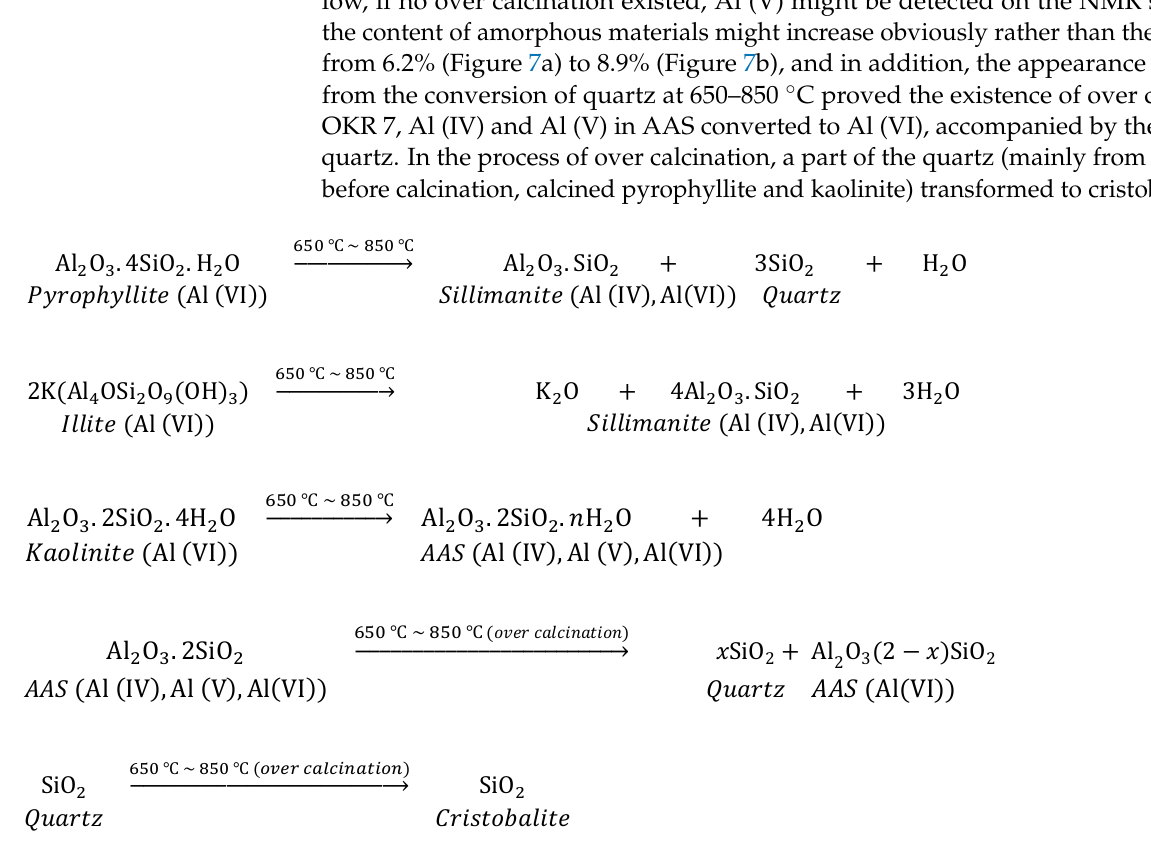
Figure 9. SEM of ordinary kaolin ( a ) and metakaolin ( b ).